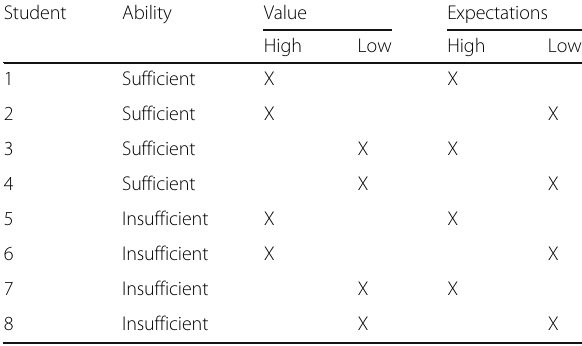
STEM fields, and expectations for success in STEM